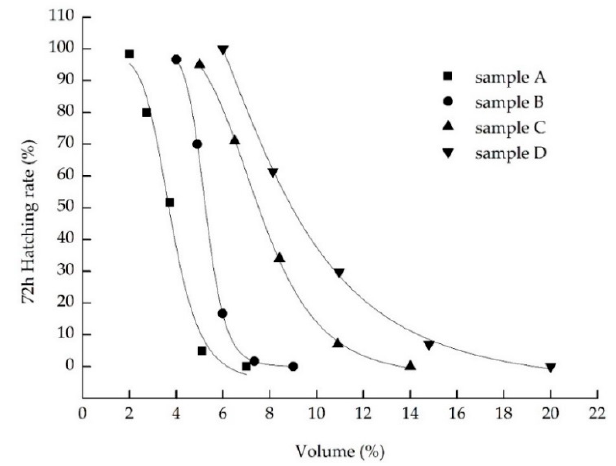
Figure 7. Seventy-two hour hatching rate on the early embryos of zebrafish exposed to four treatment process effluents. Sample A, coagulation and sedimentation tank effluent; sample B, anaerobic tank effluent; sample C, electrochemical oxidation tank effluent; and sample D, aerobic tank